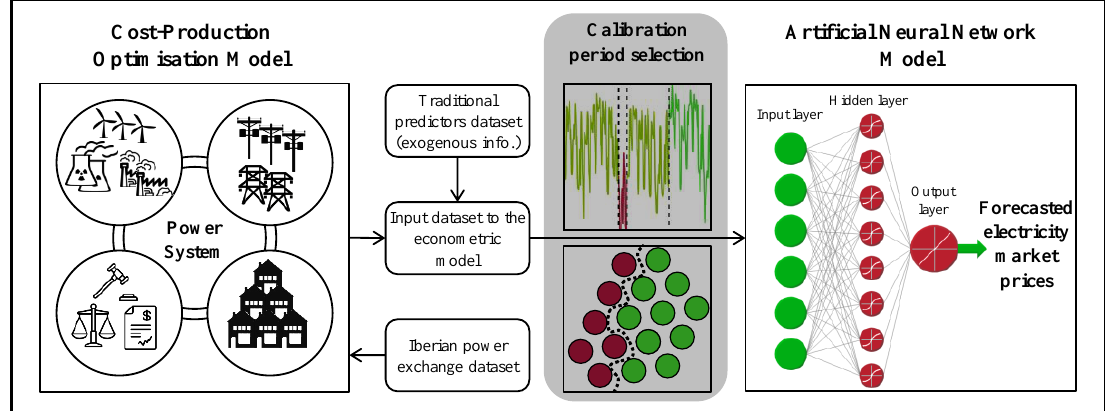
Figure 1. Overview of the proposed hybrid forecasting methodology.